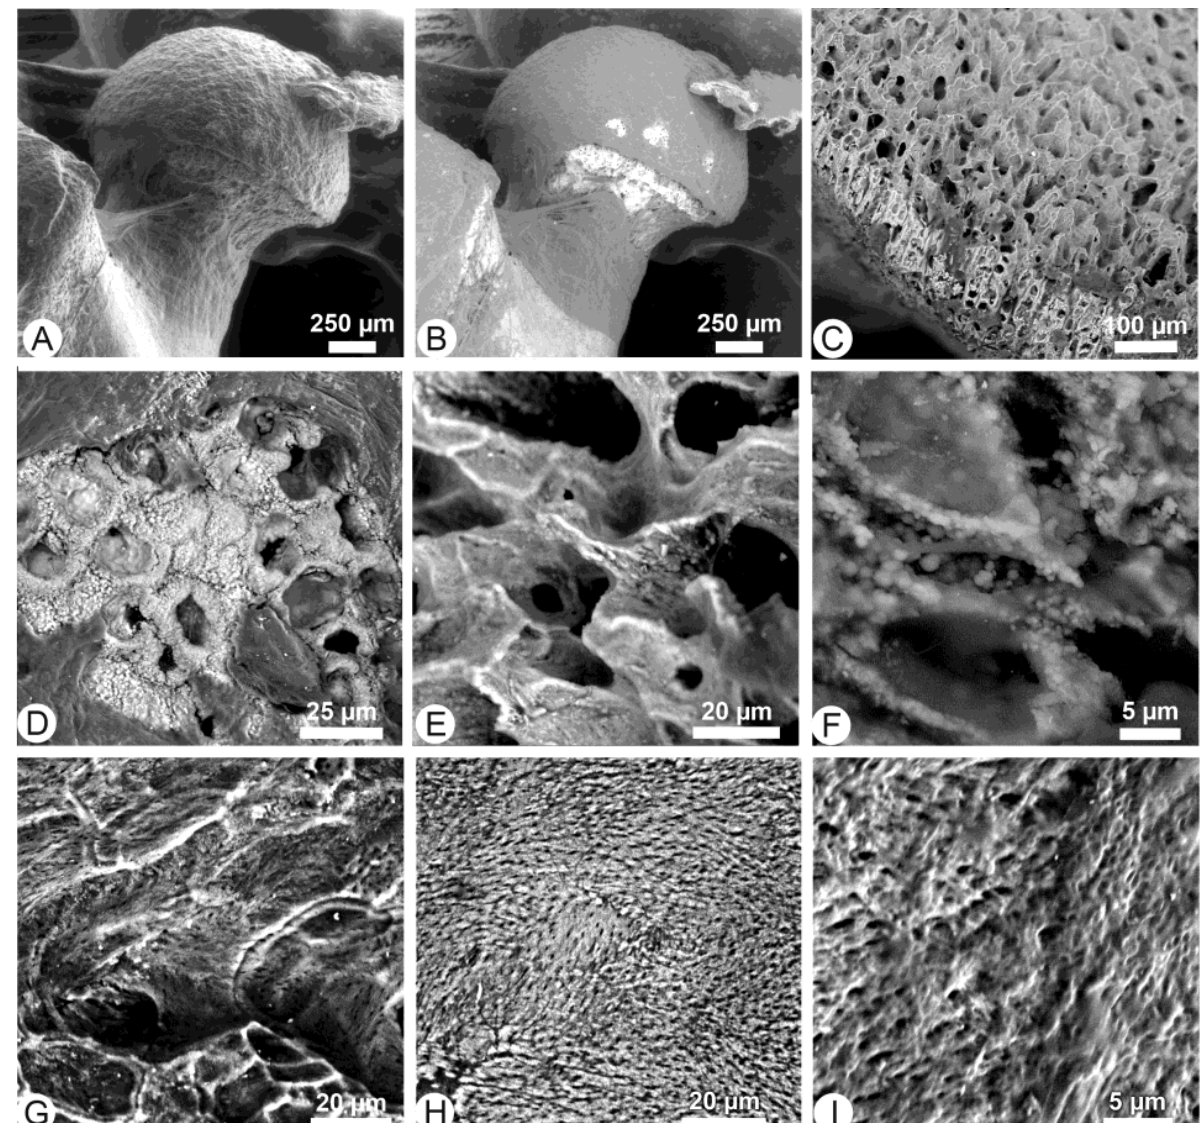
Figure 6. Tryspin and lipase etchings. ( A , B ). Irregular etching of the epiphysis of a femur of Apode- mus ; SE ( A ) and BSE ( B ) images. ( C ). Fractured tibia of Apodemus . ( D ). Irregular etching of the epiphysis of a femur of Apodemus; BSE image). ( E , F ). Cancellous zone of a tibia Apodemus showing small, rounded granules. ( G – I ). Bone resorption patterns in the same sample ( G , H ) and in the femur of Mus musculus ( I ).